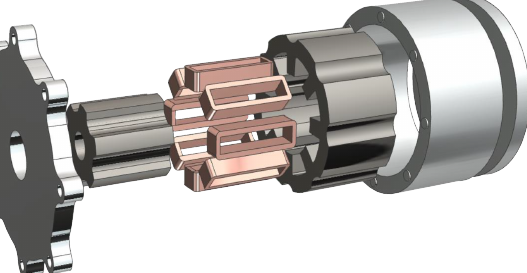
Figure 25. Exploded view of Design I with improved bolt and flange mounts and with stator back iron